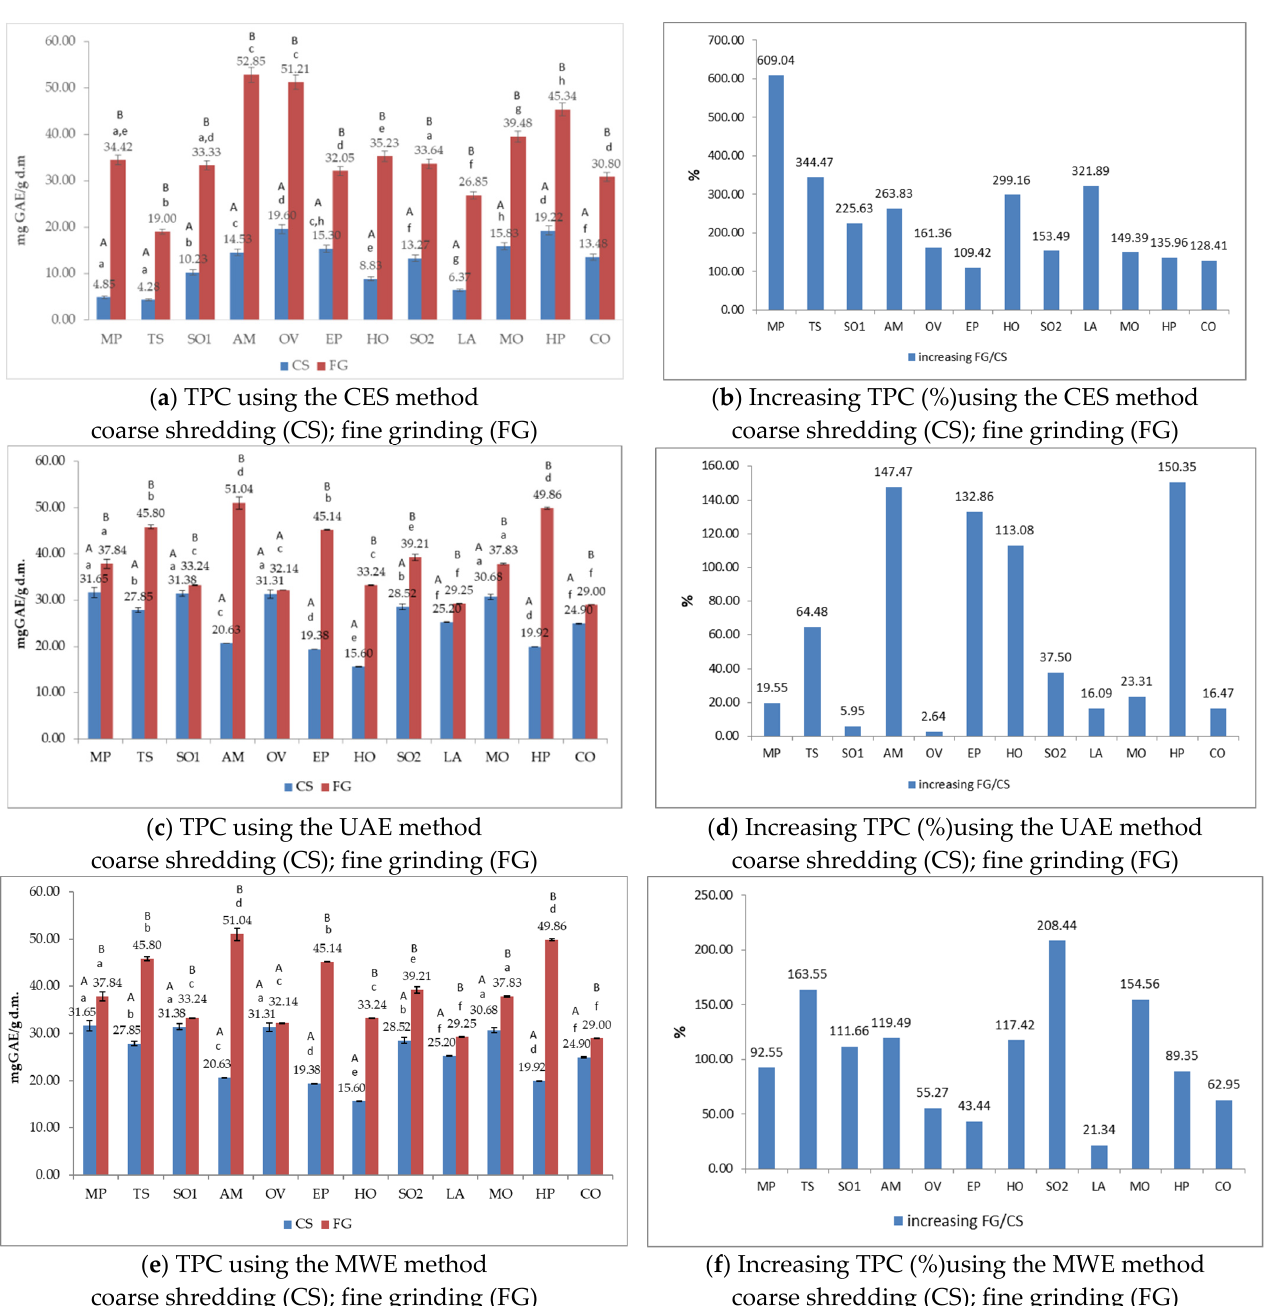
Figure 2. TPC content for CS/FG samples extracted by CES, UAE, and MWE methods. According to the t -test, the different lower-case letters (a–f represent the significant differences ( p < 0.05) between samples obtained by the same shredding method. The different capital letters (A, B) represent the significant differences ( p < 0.05) between samples from the same plant obtained by different shredding methods.